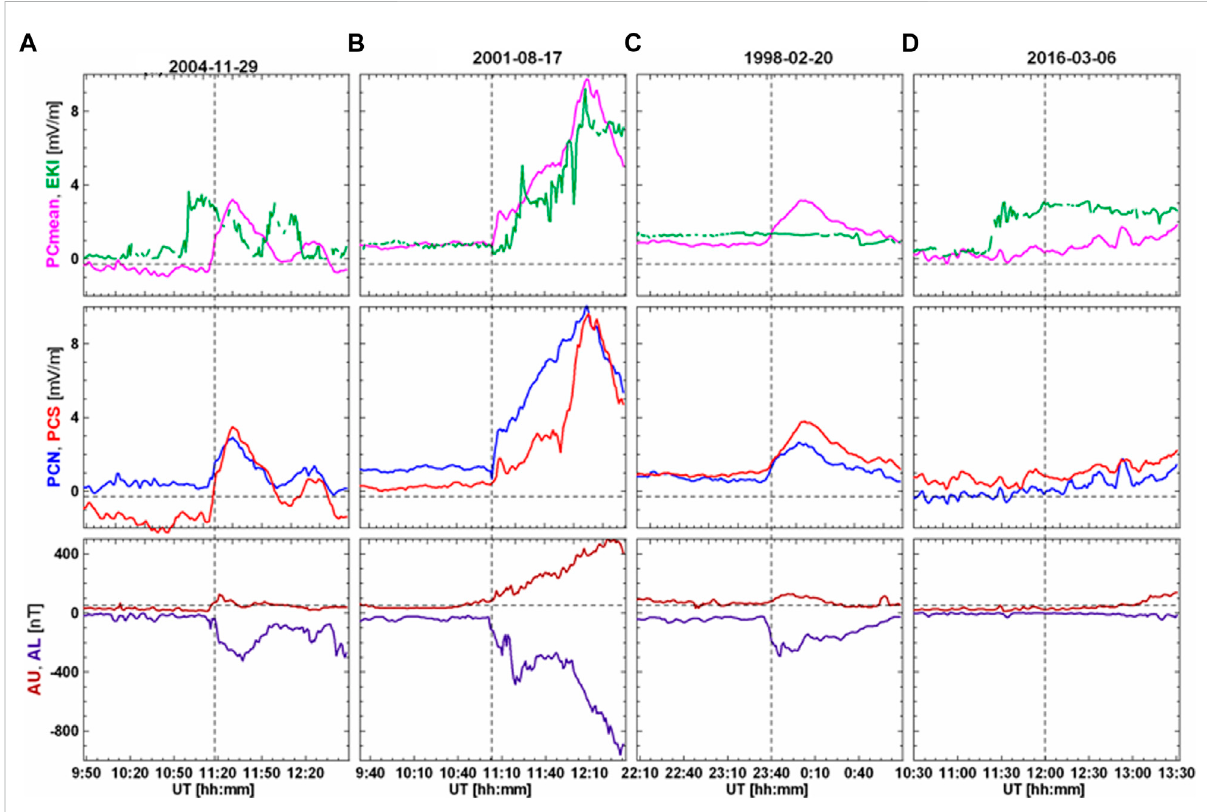
FIGURE 9 Examples of coordinated changes of EKL fi eld and PCmean index (upper panel), PCN and PCS indices (middle panel), AU and AL indices (lower panel) in course of isolated magnetic substorms (Troshichev and Sormakov, 2019b): (A) Disturbance started against the background of quiet magnetic fi eld in connection with the PC growth responding to the EKL fi eld increase; (B) Jump of PC index and the substorm onset was registered ~10 min ahead of the appropriate EKL fi eld increase on the magnetopause; (C) The EKL fi eld was unchanged and quiet, whereas PC index demonstrated jump above 2 mV/m, which was accompanied by the substorm development; (D) The EKL fi eld demonstrated long increase above 2 mV/m but this increase was not followed by the PC index growth and substorm